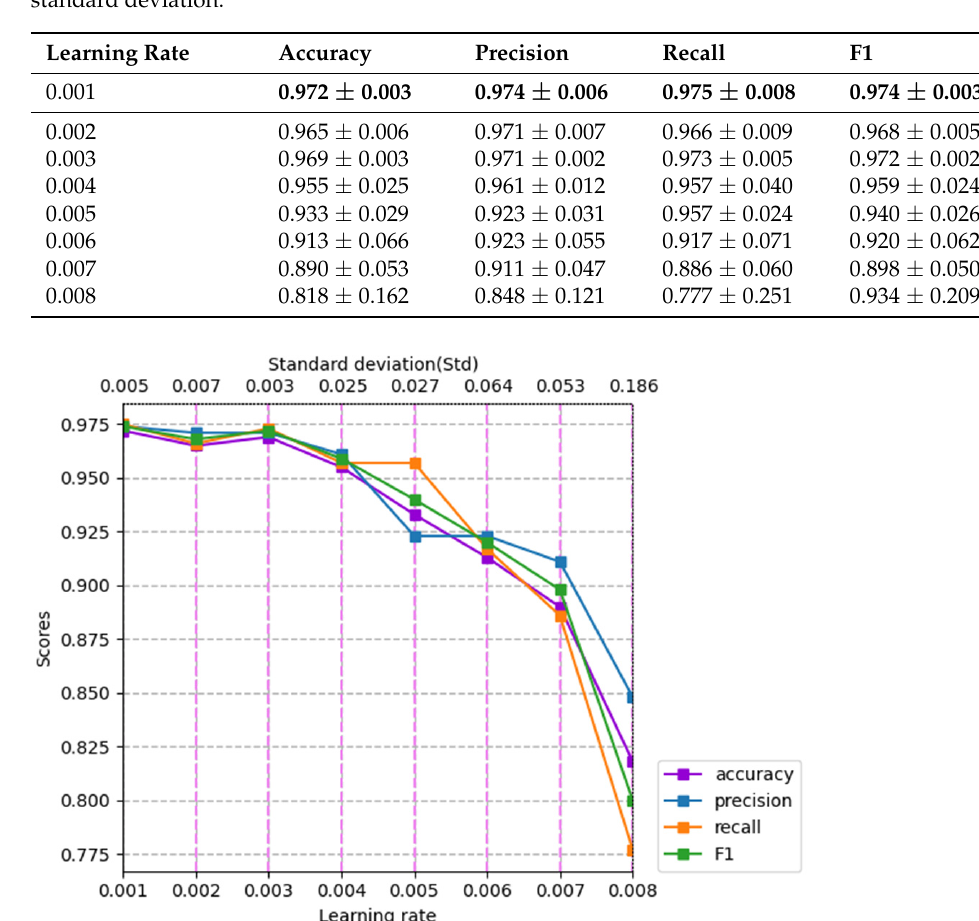
Figure 5. Model performance comparison of different learning rates on the Chinese review dataset. The value at the top of the violet dotted line represents the average of the standard deviations of all evaluation metrics scores corresponding to different dropout values.